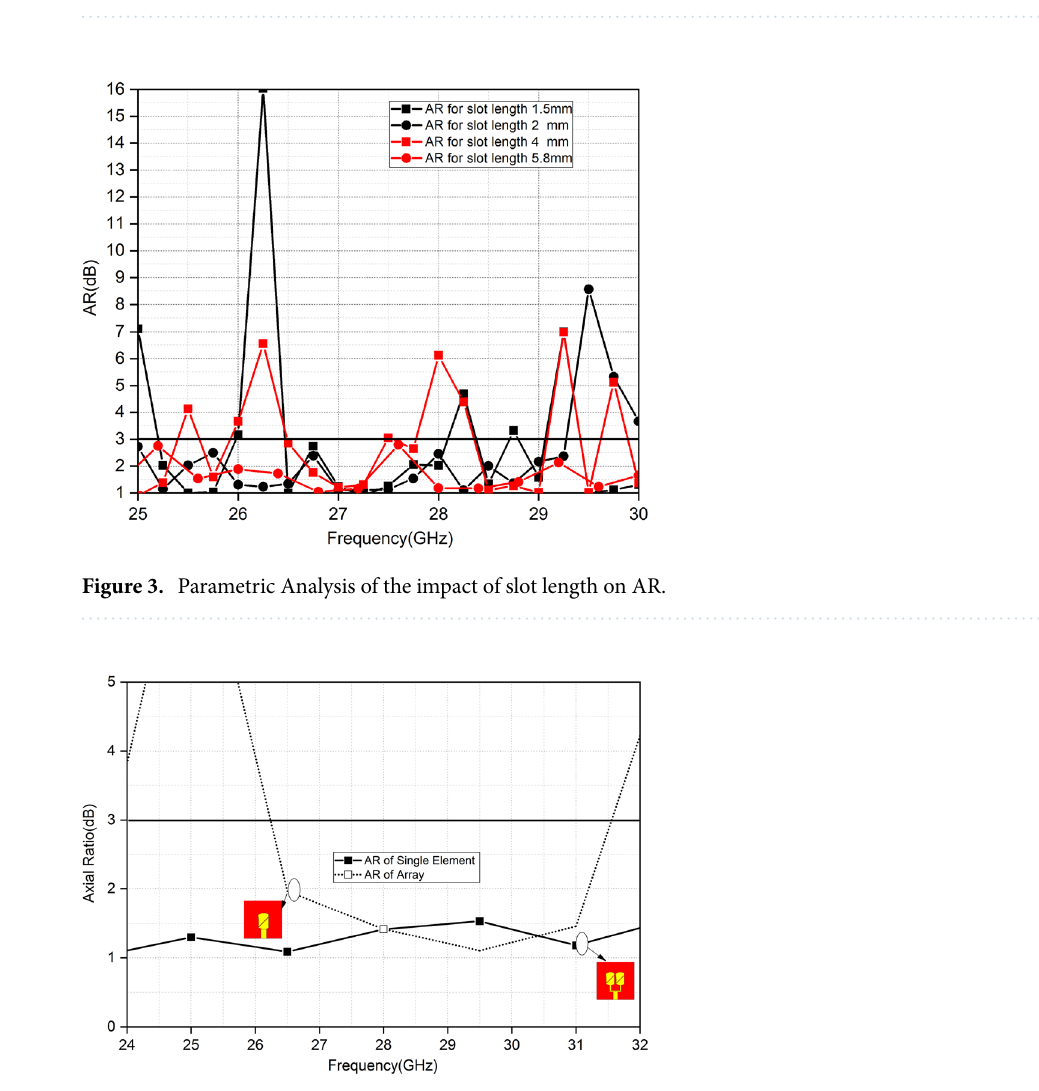
Figure 2. Reflection coefficient of design evaluation.